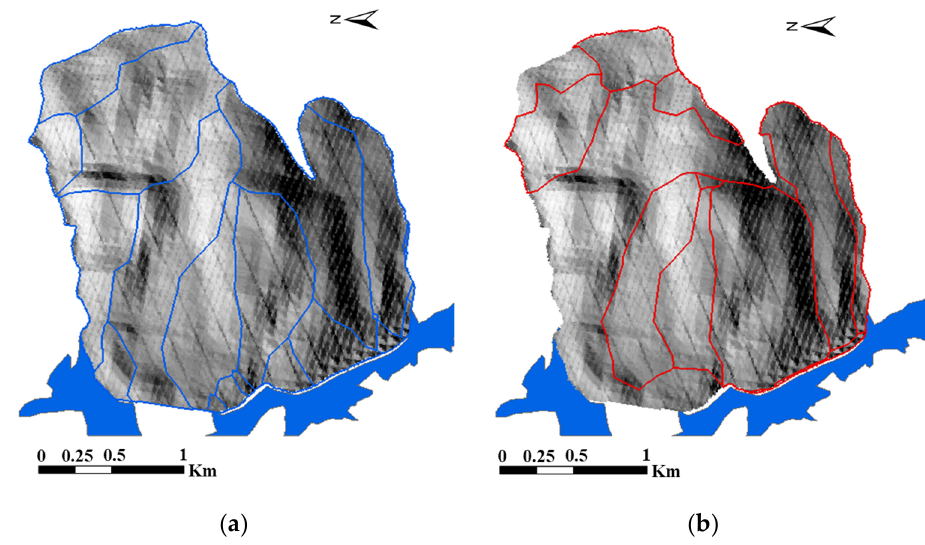
Figure 14. The slope unit extraction process of conventional method of Jijing landslide: ( a ) the divide lines extracted from normal DEM and ( b ) the drainage lines extracted from reverse DEM.